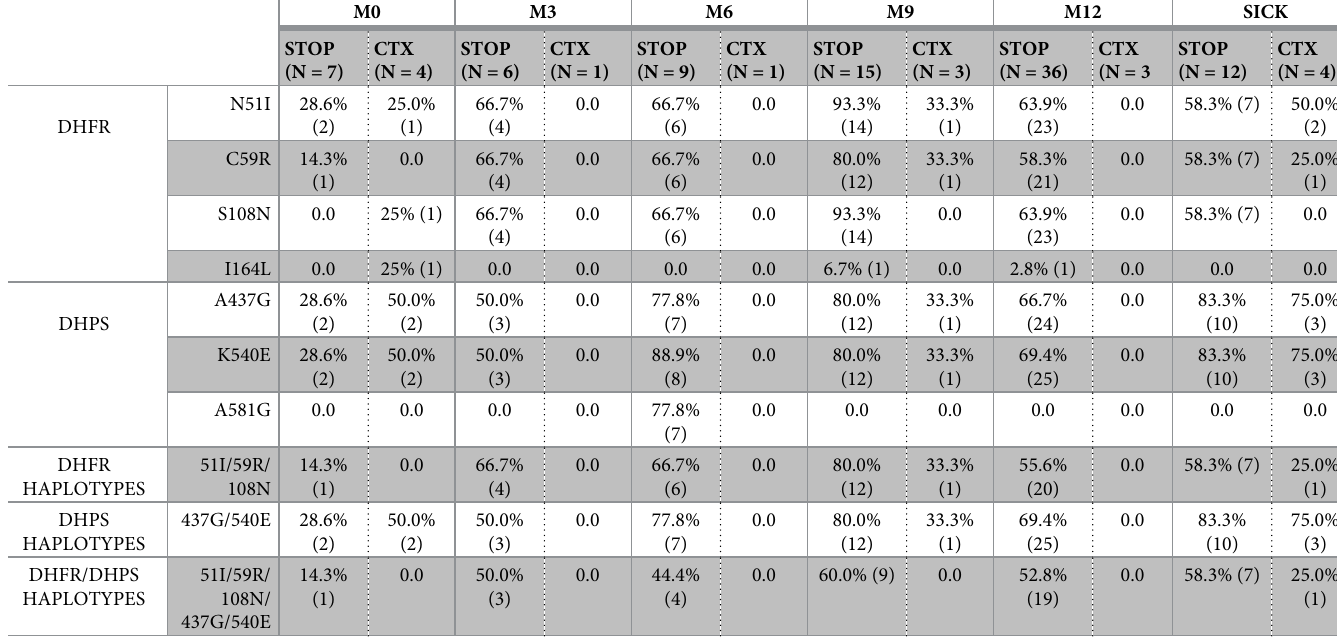
Table 2. Temporal change of mutations in the pfdhfr and pfdhps